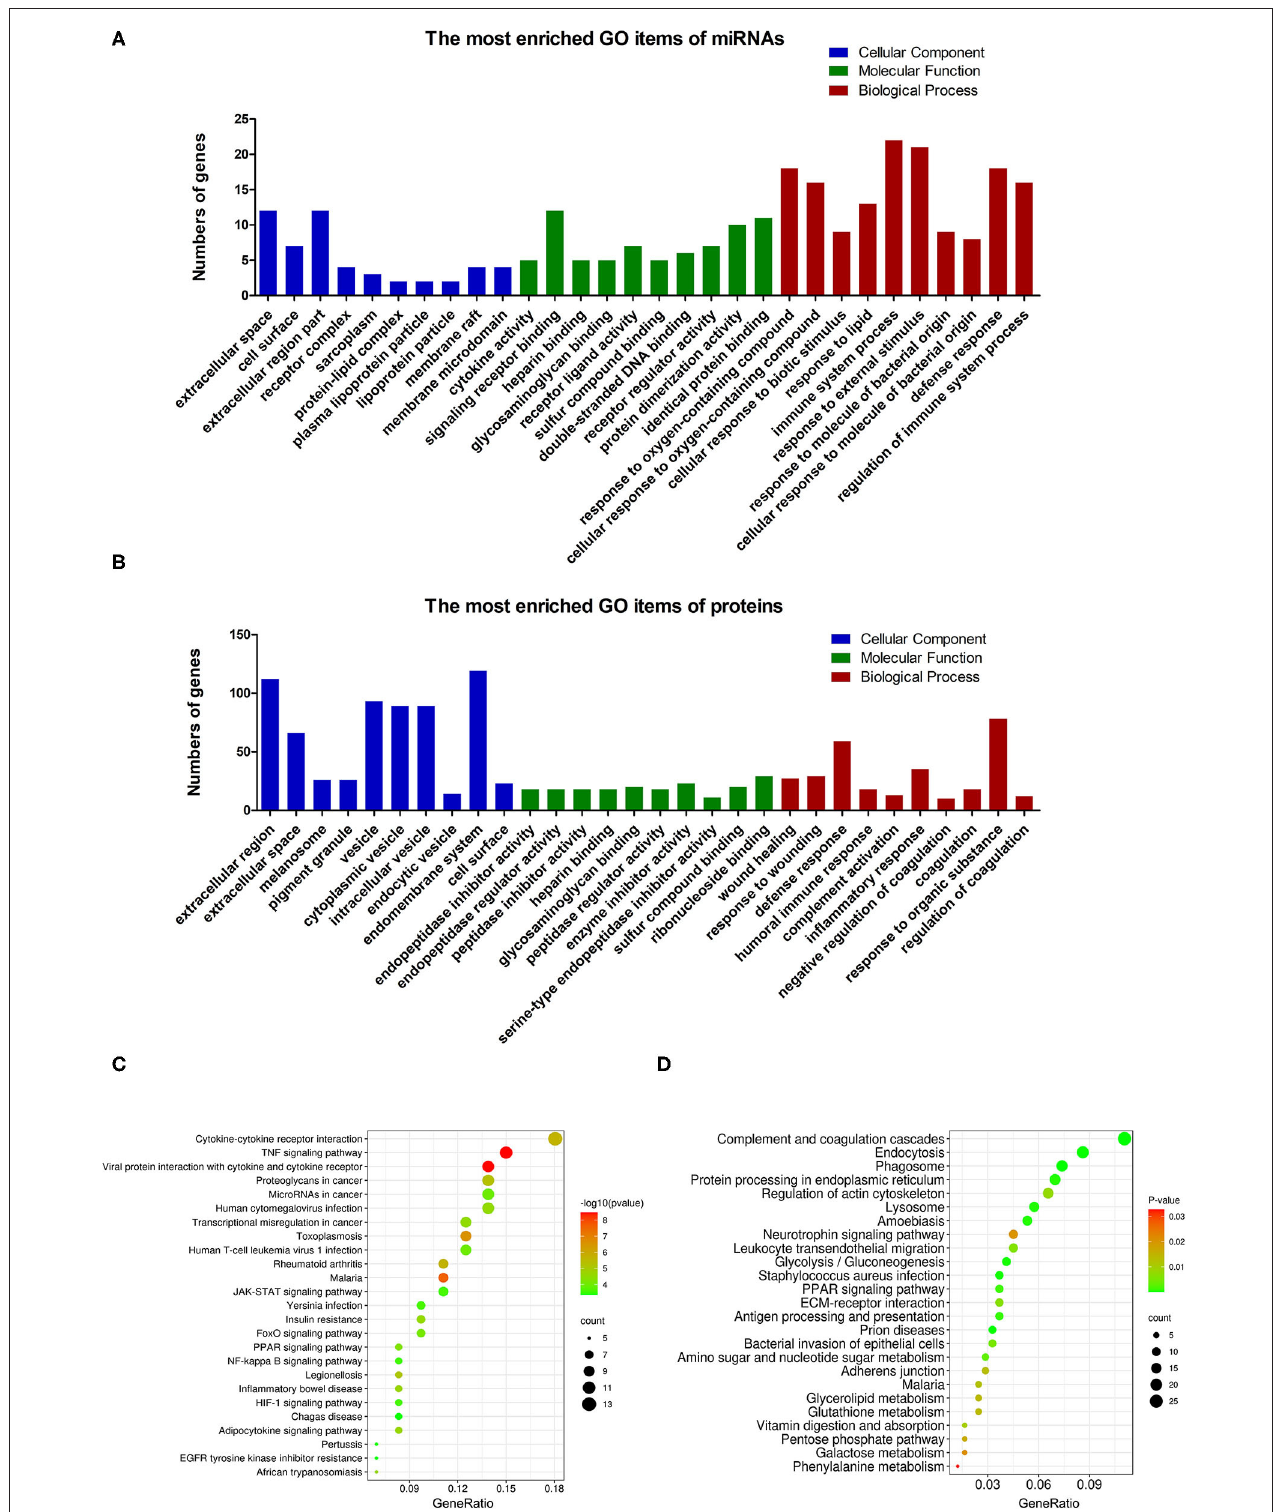
FIGURE 5 | Bioinformatic analysis based on small RNA sequencing and proteomic profiling of BM-EVs. GO enrichment analysis of the differentially regulated microRNAs (A) and proteins (B) was performed. The enriched terms were ranked in ascending order of P-values from left to right, indicating that the P-value of the first column in each section was the minimum. The enriched KEGG pathways of the differentially regulated microRNAs (C) and proteins (D) were illustrated using a bubble plot.